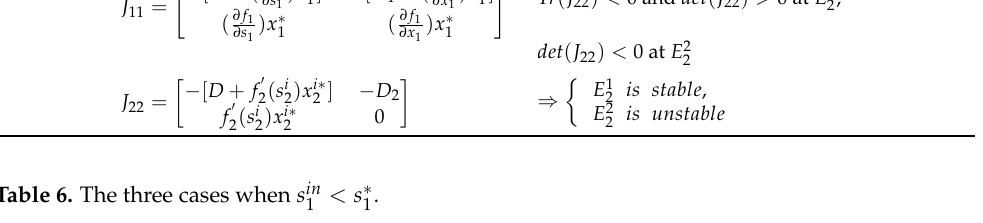
Table 6. The three cases when s in